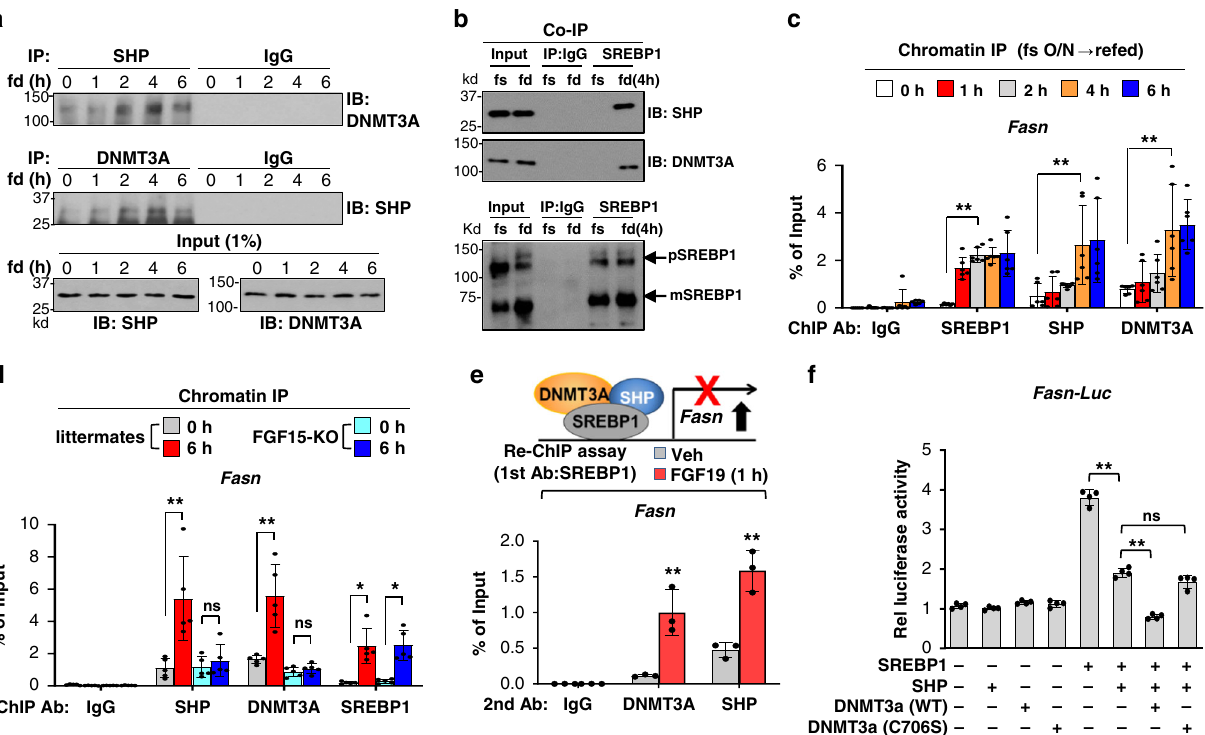
Fig. 5 SHP and DNMT3A inhibit SREBP1-mediated induction of Fasn in the late fed state. a – c C57BL/6 mice were fed (fd) for the indicated times after fasting overnight (fs). Interaction of ( a ) DNMT3A with SHP or of ( b ) SREBP1 with SHP or DNMT3A in liver extracts determined by CoIP. c Occupancy of SREBP1, SHP, and DNMT3A at the Fasn promoter determined by ChIP. d FGF15-KO mice or littermates were fed for 6 h after overnight fasting. Occupancies of SHP, DNMT3A, or SREBP1 at the hepatic Fasn promoter determined by ChIP. e C57BL/6 mice were treated with FGF19 for 1 h after fasting overnight. Co- occupancy of SHP or DNMT3A with SREBP1 at the Fasn promoter determined by sequential re-ChIP. f PMHs were transfected with plasmids as indicated for 48 h and then, treated with FGF19 (50 ng/ml) or vehicle for 6 h. Luciferase activity normalized to β -galactosidase activity. c – f Mean values ± SD are plotted ( c , n = 6 mice; d , n = 5 mice, e , n = 3 mice, f , n = 4 mice). Statistical signi fi cance was determined by ( c – e ) two-way ANOVA or ( f ) one-way ANOVA with the Tukey post-test. * P < 0.05, ** P < 0.01, ns, statistically not signi fi